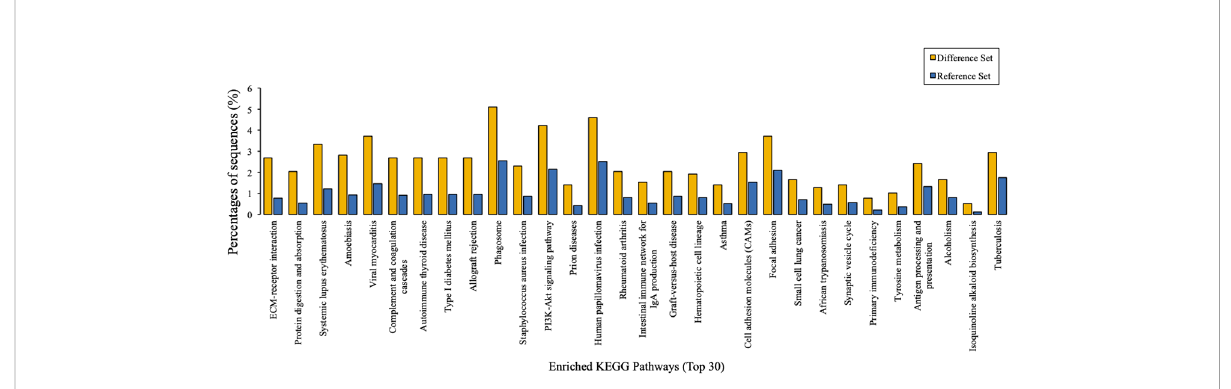
FIGURE 5 KEGG pathway enrichment analysis results. The top 30 enriched pathways of target proteins were displayed in comparison with background proteins. Difference set: target proteins; Reference set: background